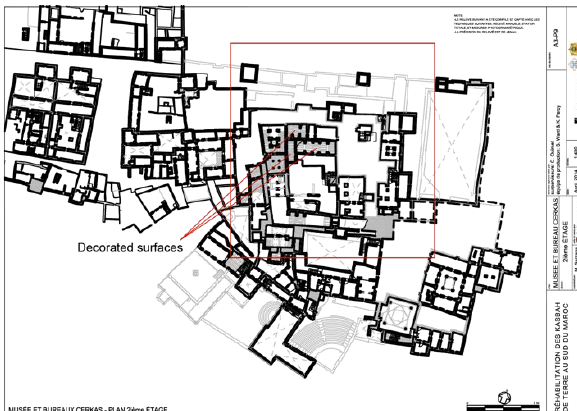
Figure 5: Second floor plan of the Caïd Residence with Kasbah Taourirt indicating location of rooms with decorated